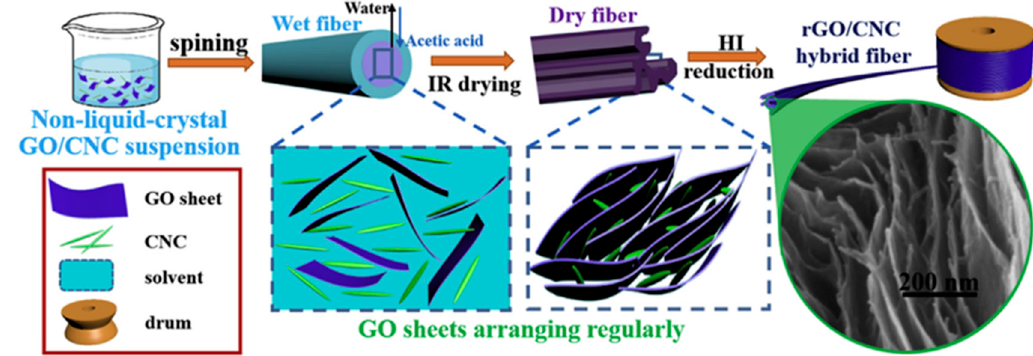
Figure 13. Schematic illustration of the preparation of CNC/RGO hybrid fiber. Reproduced with permission from Reference [130]. Copyright ©2018, Elsevier.